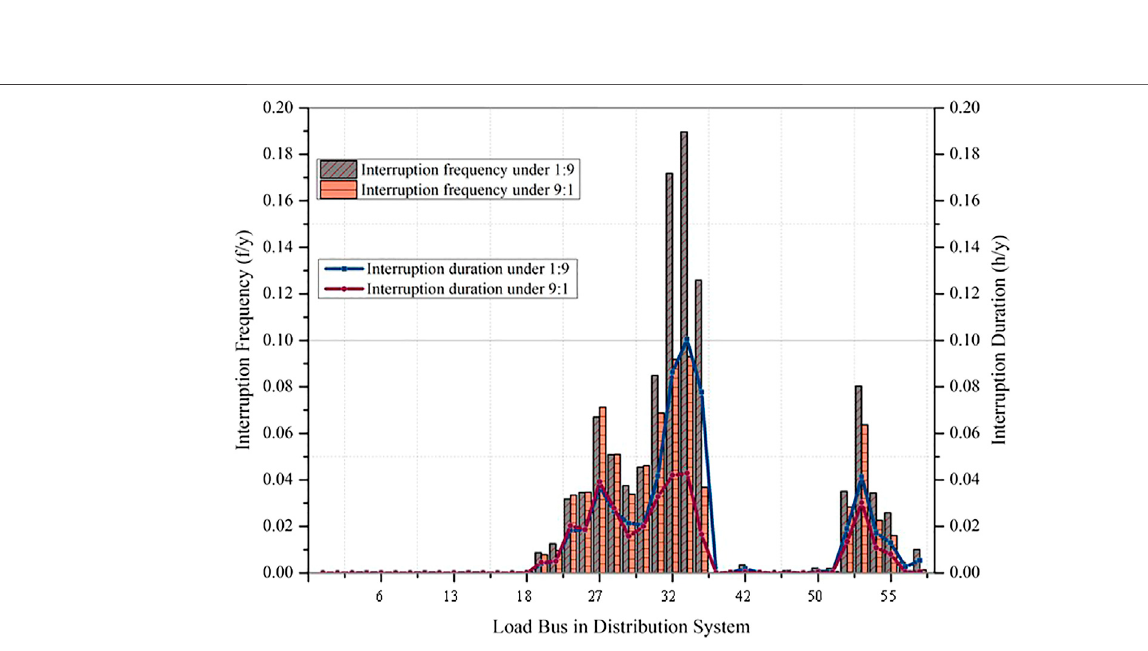
FIGURE 11 | Interruption frequency and duration based trip chain of 1:9 and